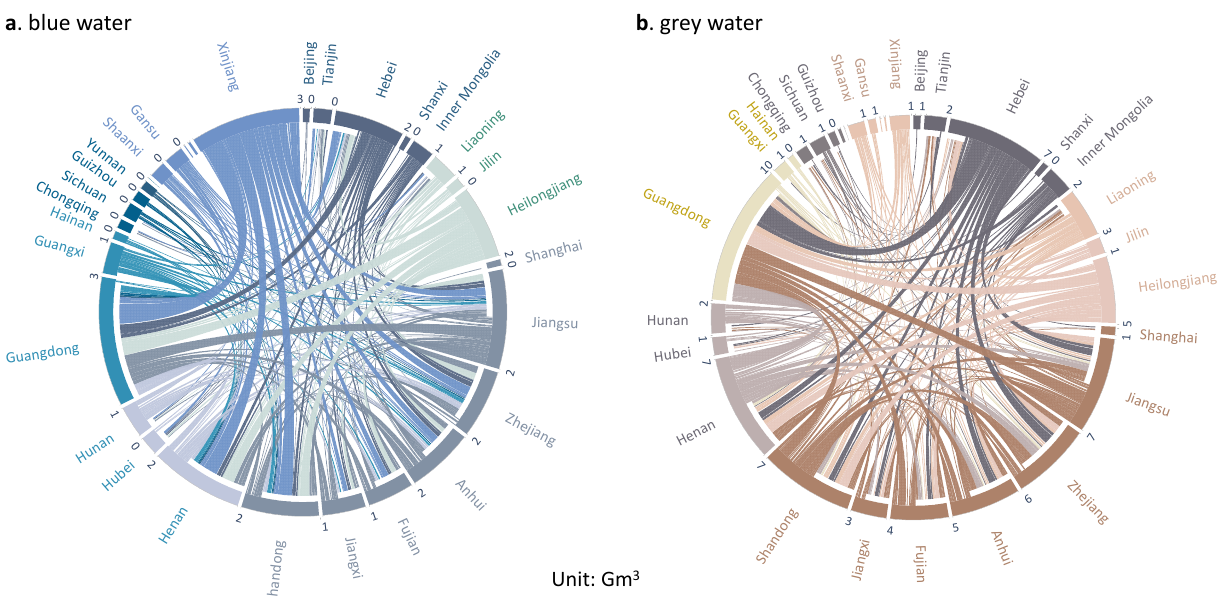
Figure 3. Blue ( a ) and grey ( b ) water flows among 31 regions in China’s apparel manufacturing in 2015. The spatial transfer pattern of grey water in China’s apparel manufacturing in 2015 is shown in Figure 3b. The total grey water flows in the apparel supply chain were 39.55 Gm 3 . The largest grey water flow was from Hebei to Guangdong (1.31 Gm 3 ), following by Henan–Guangdong (0.94 Gm 3 ), Heilongjiang–Guangdong (0.90 Gm 3 ) and Jiangsu–Guangdong (0.90 Gm 3 ). Guangdong was the largest grey water receiver with a net inflow of 9.13 Gm 3 . The following top receivers were Zhejiang (4.55 Gm 3 ), Henan (3.73 Gm 3 ) and Jiangsu (3.51 Gm 3 ). In contrast, Hebei contributed the most grey water (5.53 Gm 3 ), occupying 14% of the total. This is following by Heilongjiang (4.42 Gm 3 ), Henan (3.72 Gm 3 ) and Shandong (3.42 Gm 3